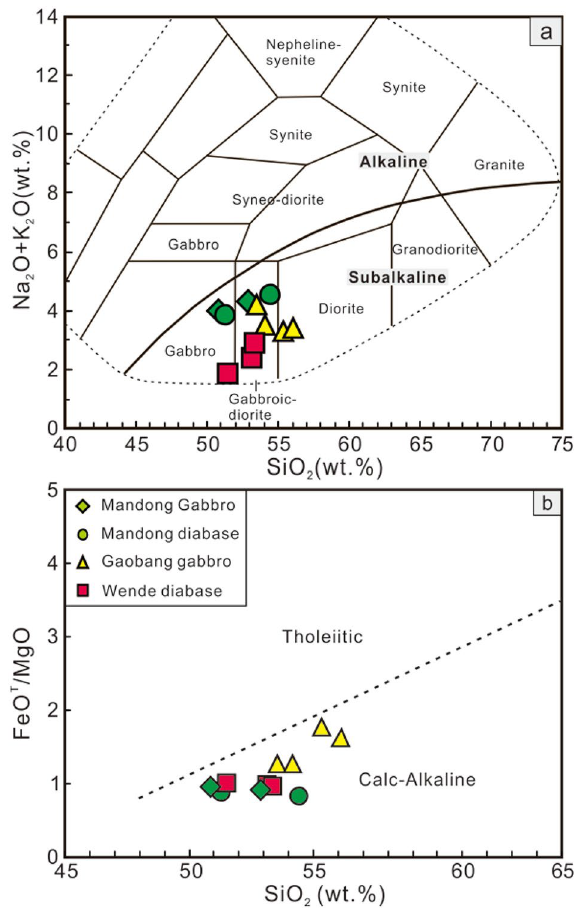
Figure 3. ( a ) Na 2 O + K 2 O versus SiO 2 diagram and ( b ) FeO T /MgO versus SiO 2 diagram for the Early Cretaceous mafic rocks in the western